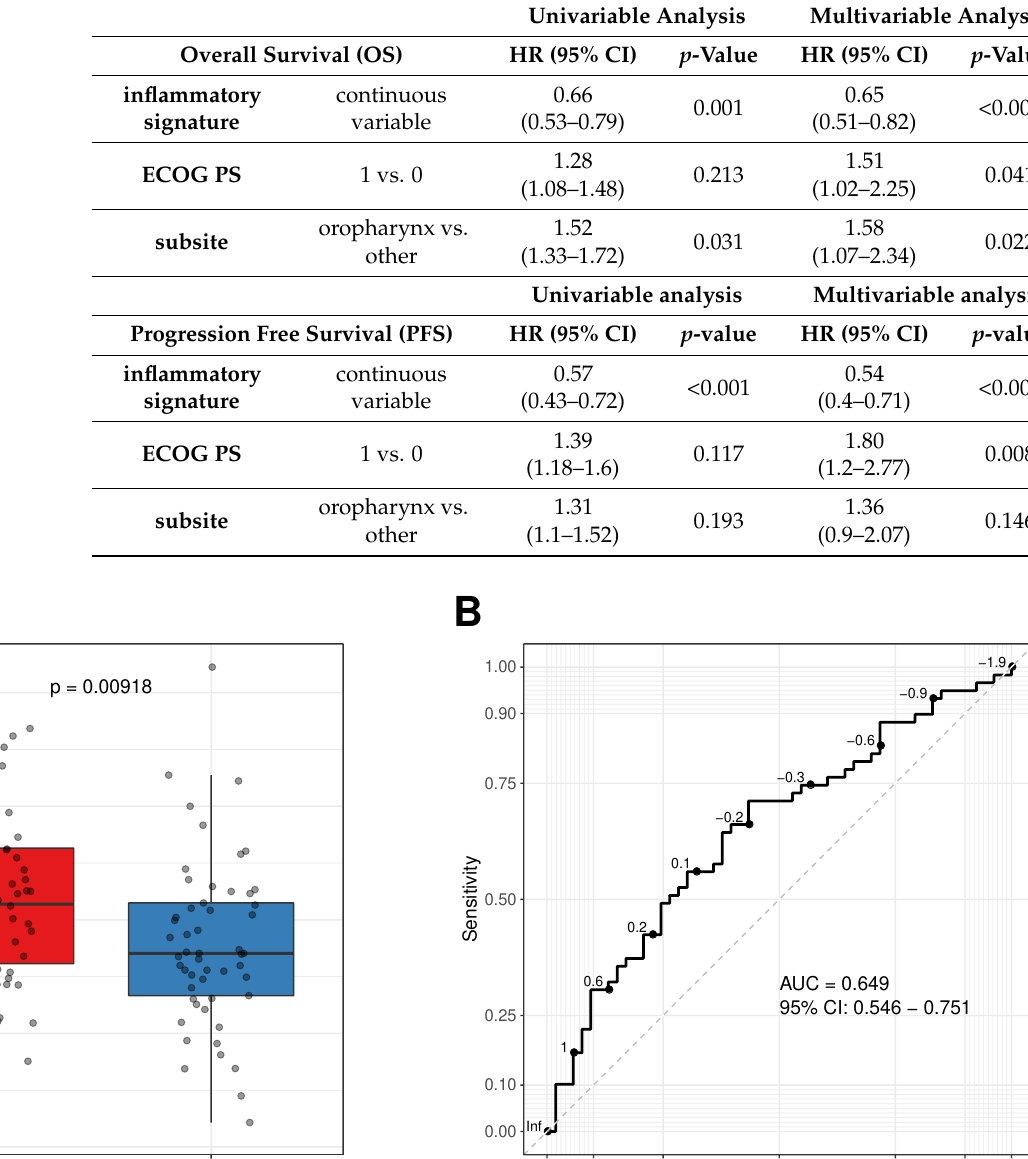
Table 2. Univariate and multivariate cox proportional hazard regression analysis of the four- gene inflammatory signature (continuous variable), considering overall survival and progression free survival.